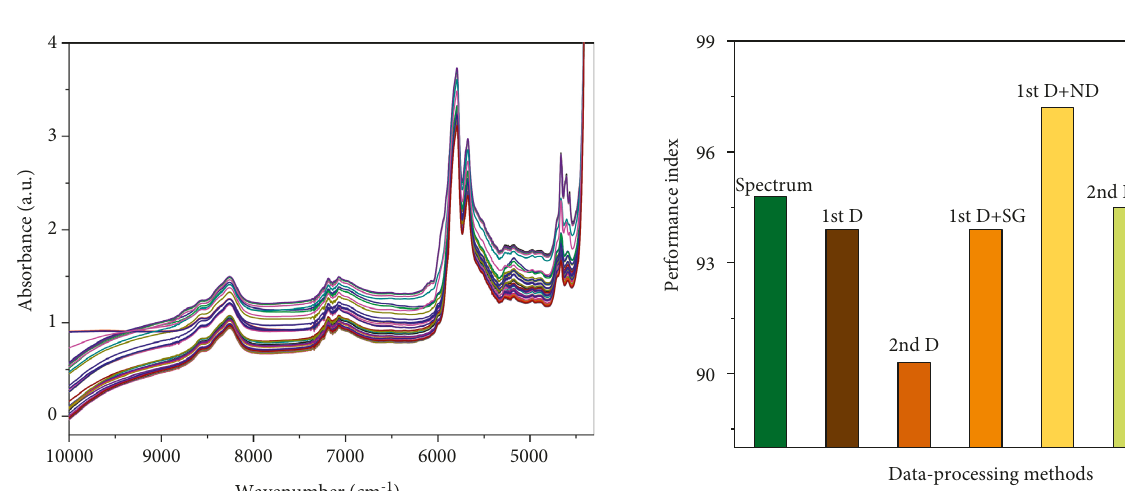
Figure 5: Performance indices of the different data-processing methods.